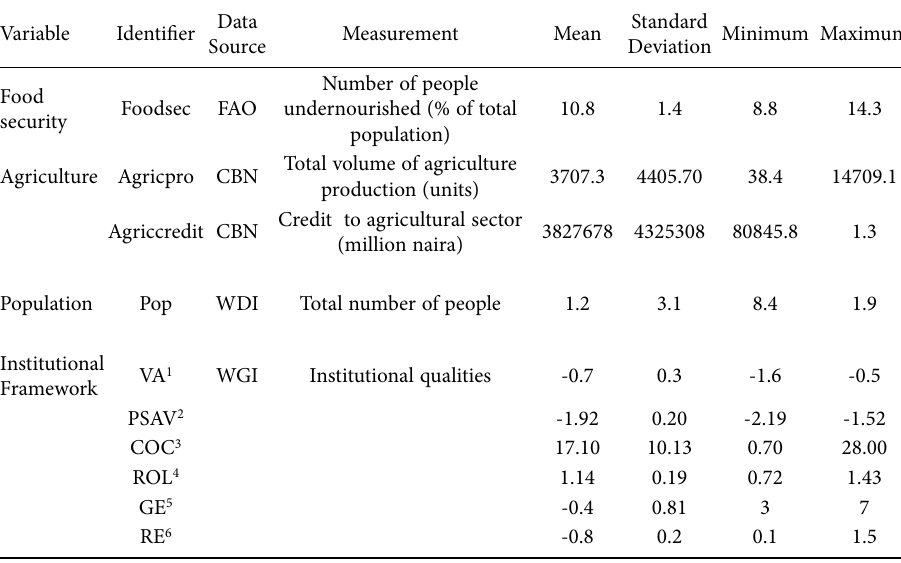
Table 1. Data sources, measurement of variables and summary